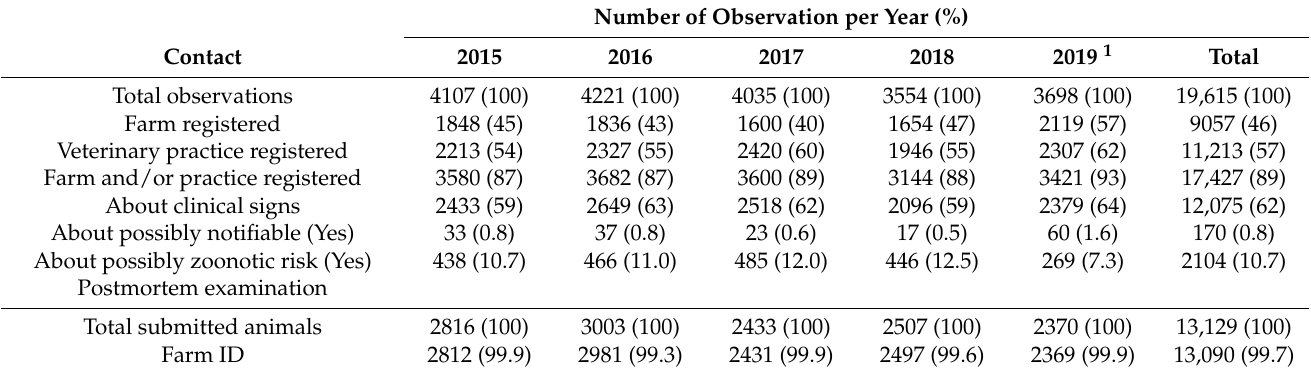
Table 4. Descriptive statistics of veterinary helpdesk contacts and postmortem examinations for cattle in the Netherlands from 2015 to 2019.